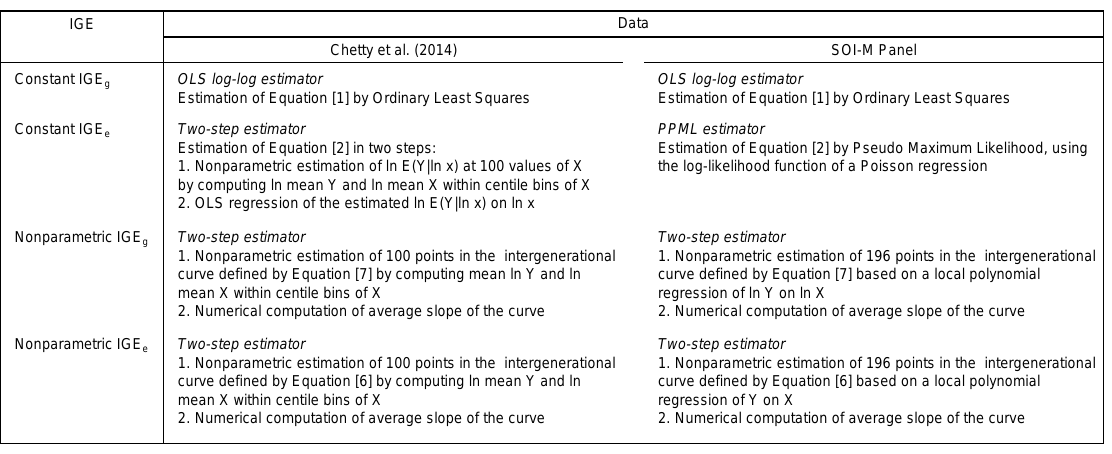
Figure 2: Estimators. To estimate all IGEs, the long-run variables in Equations (1), (2), (6), and (7) are replaced by proxy short-run